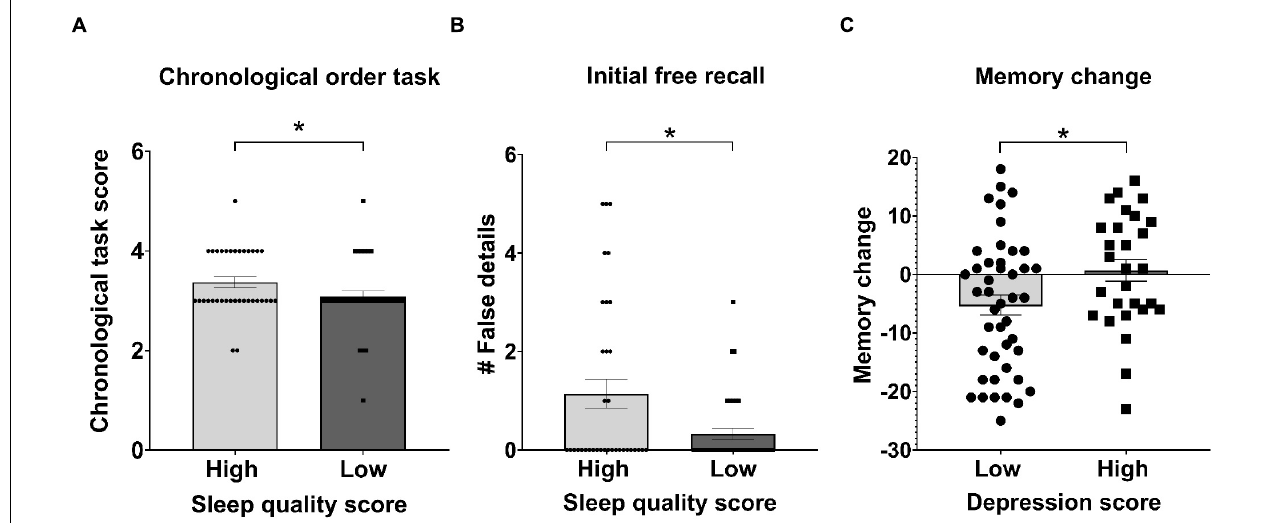
FIGURE 5 | Symptomatology scores and recall. (A) Mean of chronological order task score ± SEM, for high and low sleep score. (B) Mean number of incorrect details ± SEM on the Initial free recall, for high and low sleep quality. (C) Mean of memory change between initial recall and final recall, for high and low depressive score ± SEM. * p < 0.05, # number